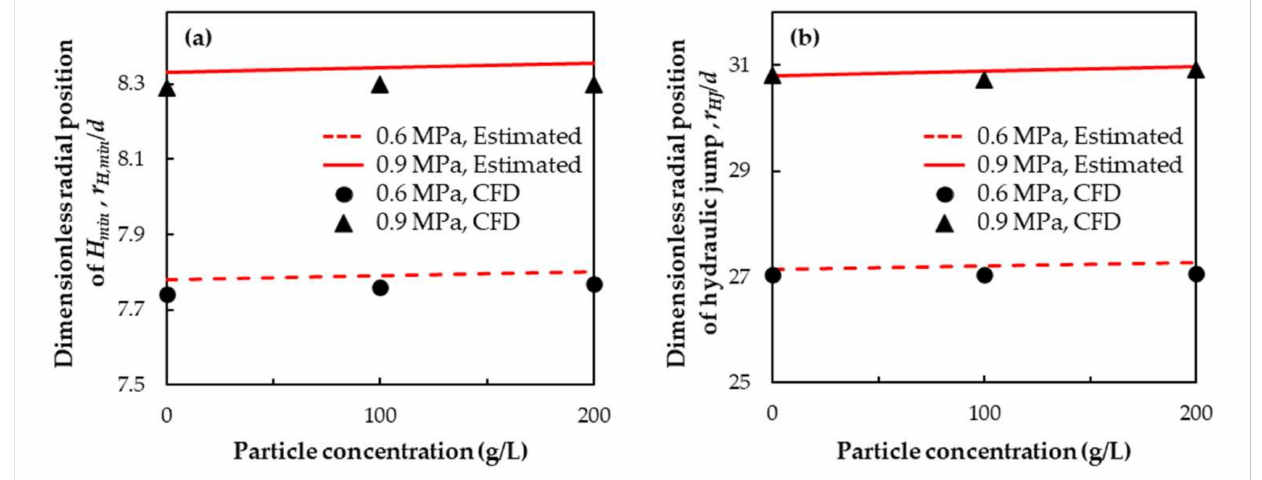
Figure 12. Comparison of the dimensionless radial position of ( a ) minimum liquid film height and ( b ) hydraulic jump obtained from CFD simulations (symbols) and empirical formulation (lines).